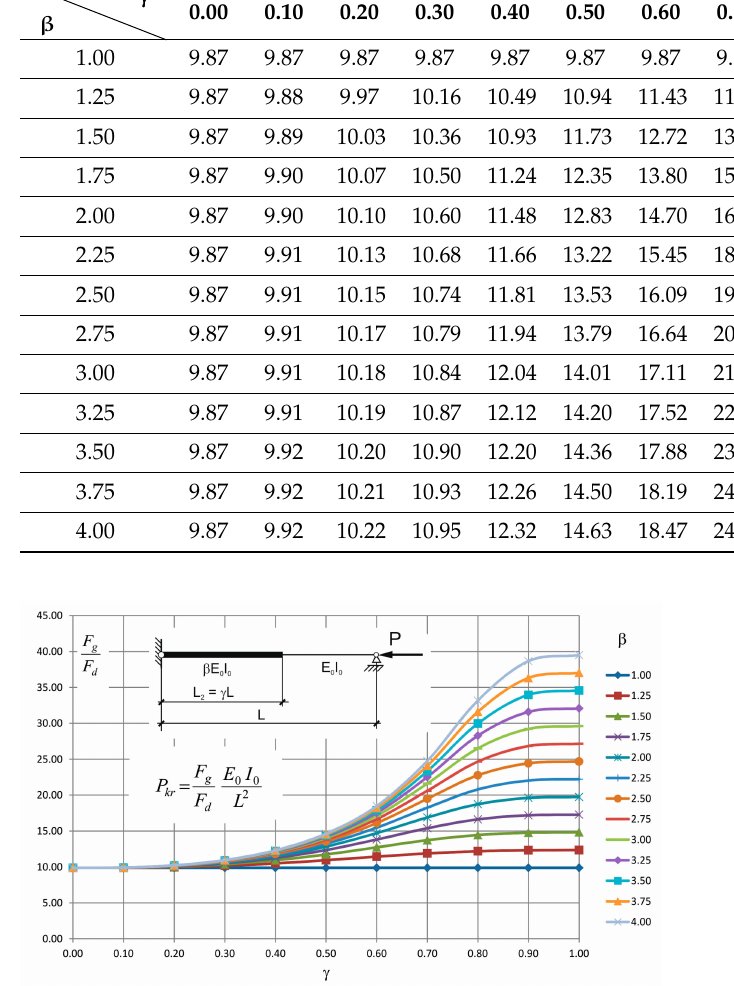
Figure 4. The ratio F g /F d for different values of β and γ